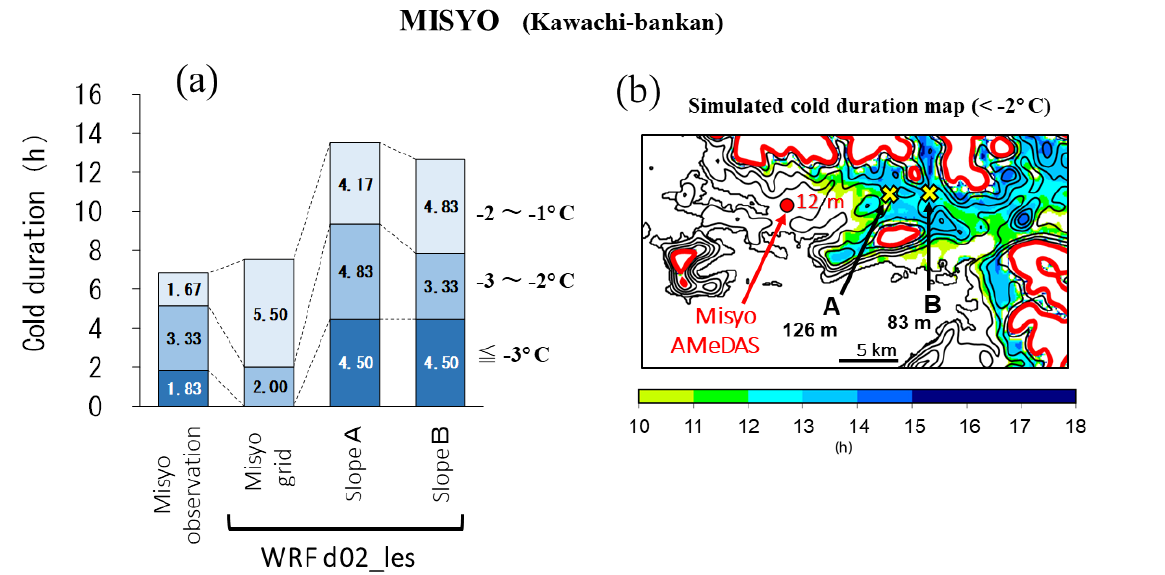
Figure 5. (a) Cold durations (h) observed at the Misyo AMeDAS site and simulated at the grids including the AMeDAS site, slope A, and slope B. (b) Simulated cold duration map (with temperature less than − 2 ◦ C) and locations of AMeDAS, slope A, and slope